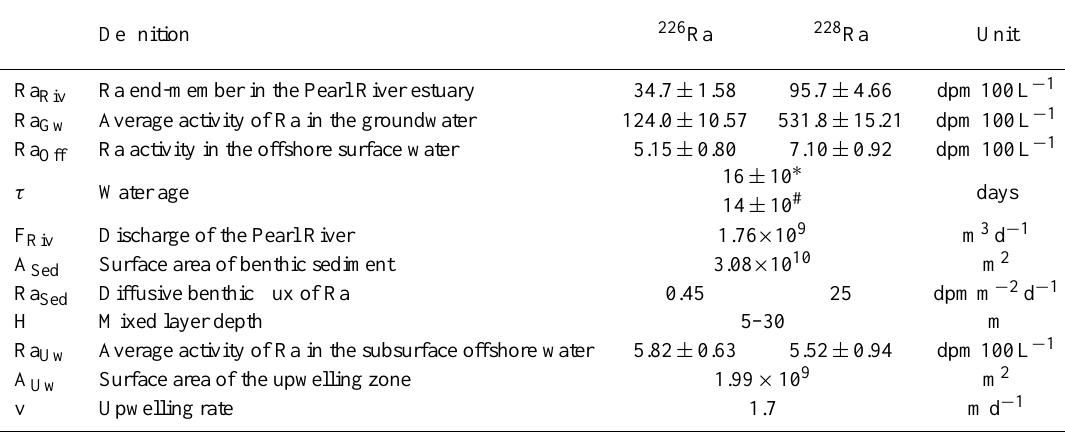
Table 4. Definitions and values used for 226 Ra and 228 Ra mass balance to estimate submarine groundwater discharge flux to the northern South China Sea.